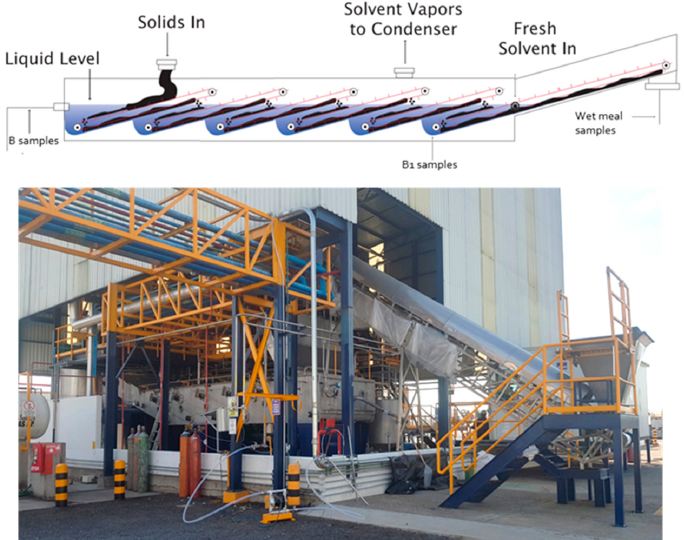
Figure 10. Counter-current extractor Crown MIV, immersion type (Crown Iron Works, Blaine, MN, USA) installed at Enat Internationalfacility (Salamanca, Mexico).